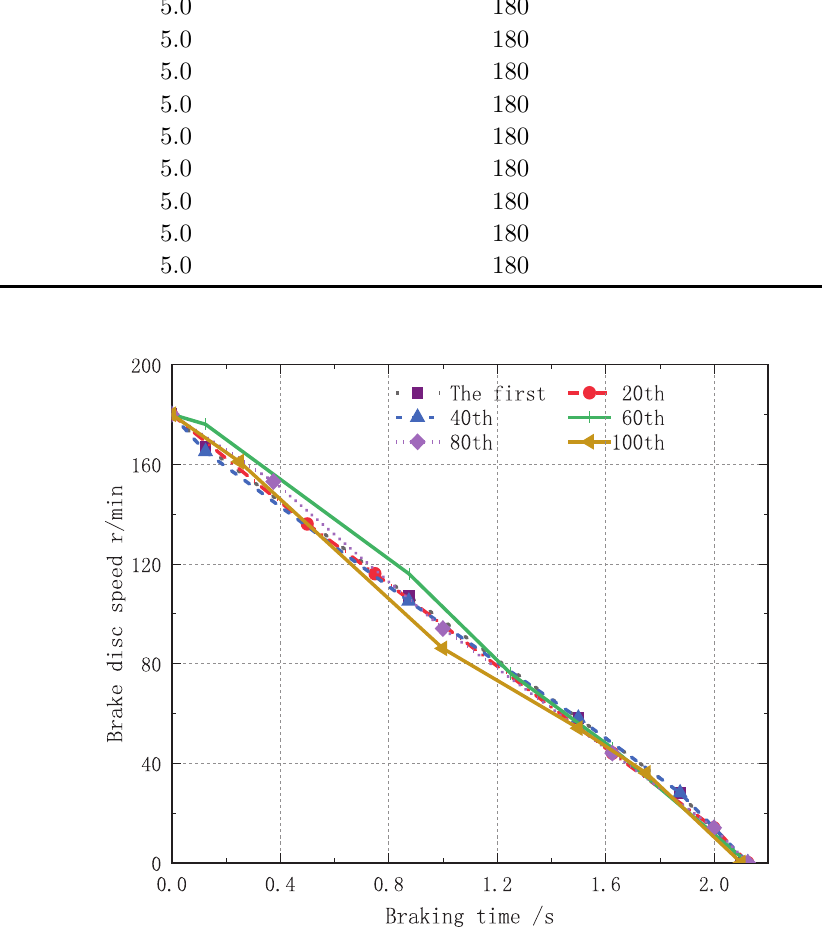
Fig. 16. Diagram of reliability performance test